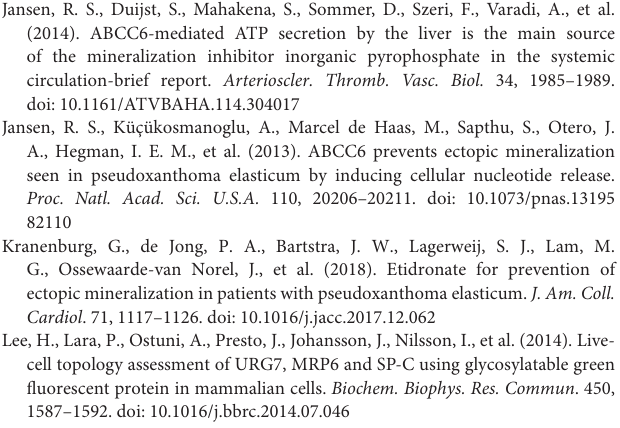
Supplemental Figure S1 | Inhibition of efflux of doxorubicin by Probenecid. Doxorubicin efflux assay in HEK293 cells stably transfected